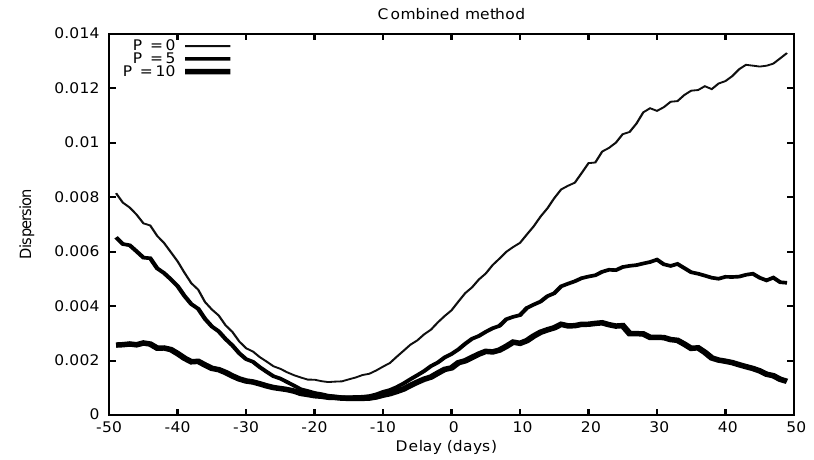
Fig. 4. Combined dispersion spectra for Kochanek et al. (2006)